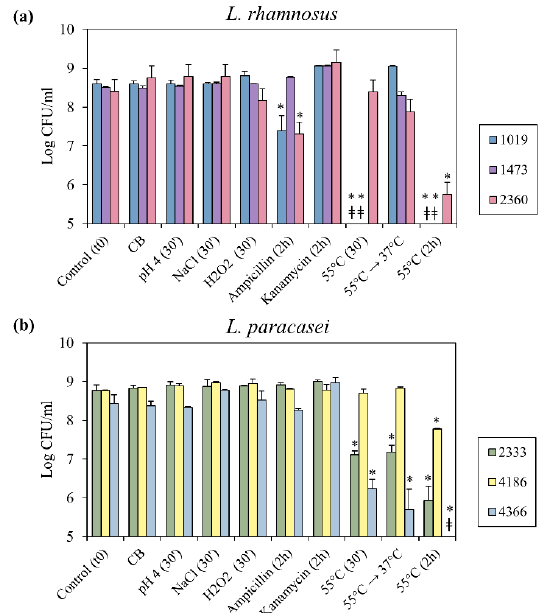
Figure 2. Bacterial culturability after exposure to stress conditions. Plate counts of ( a ) L. rhamnosus strains, ( b ) L. paracasei strains exposed to the indicated stress conditions. ‡, bacterial loads below the limit of detection (set at 5 Log CFU / mL); lower dilution (until 10 − 2 ) were assayed for these samples, but no colonies were observed after 48 h of incubation. Error bars represent the standard error of the mean (SEM, n = 2). * significant di ff erence, p <